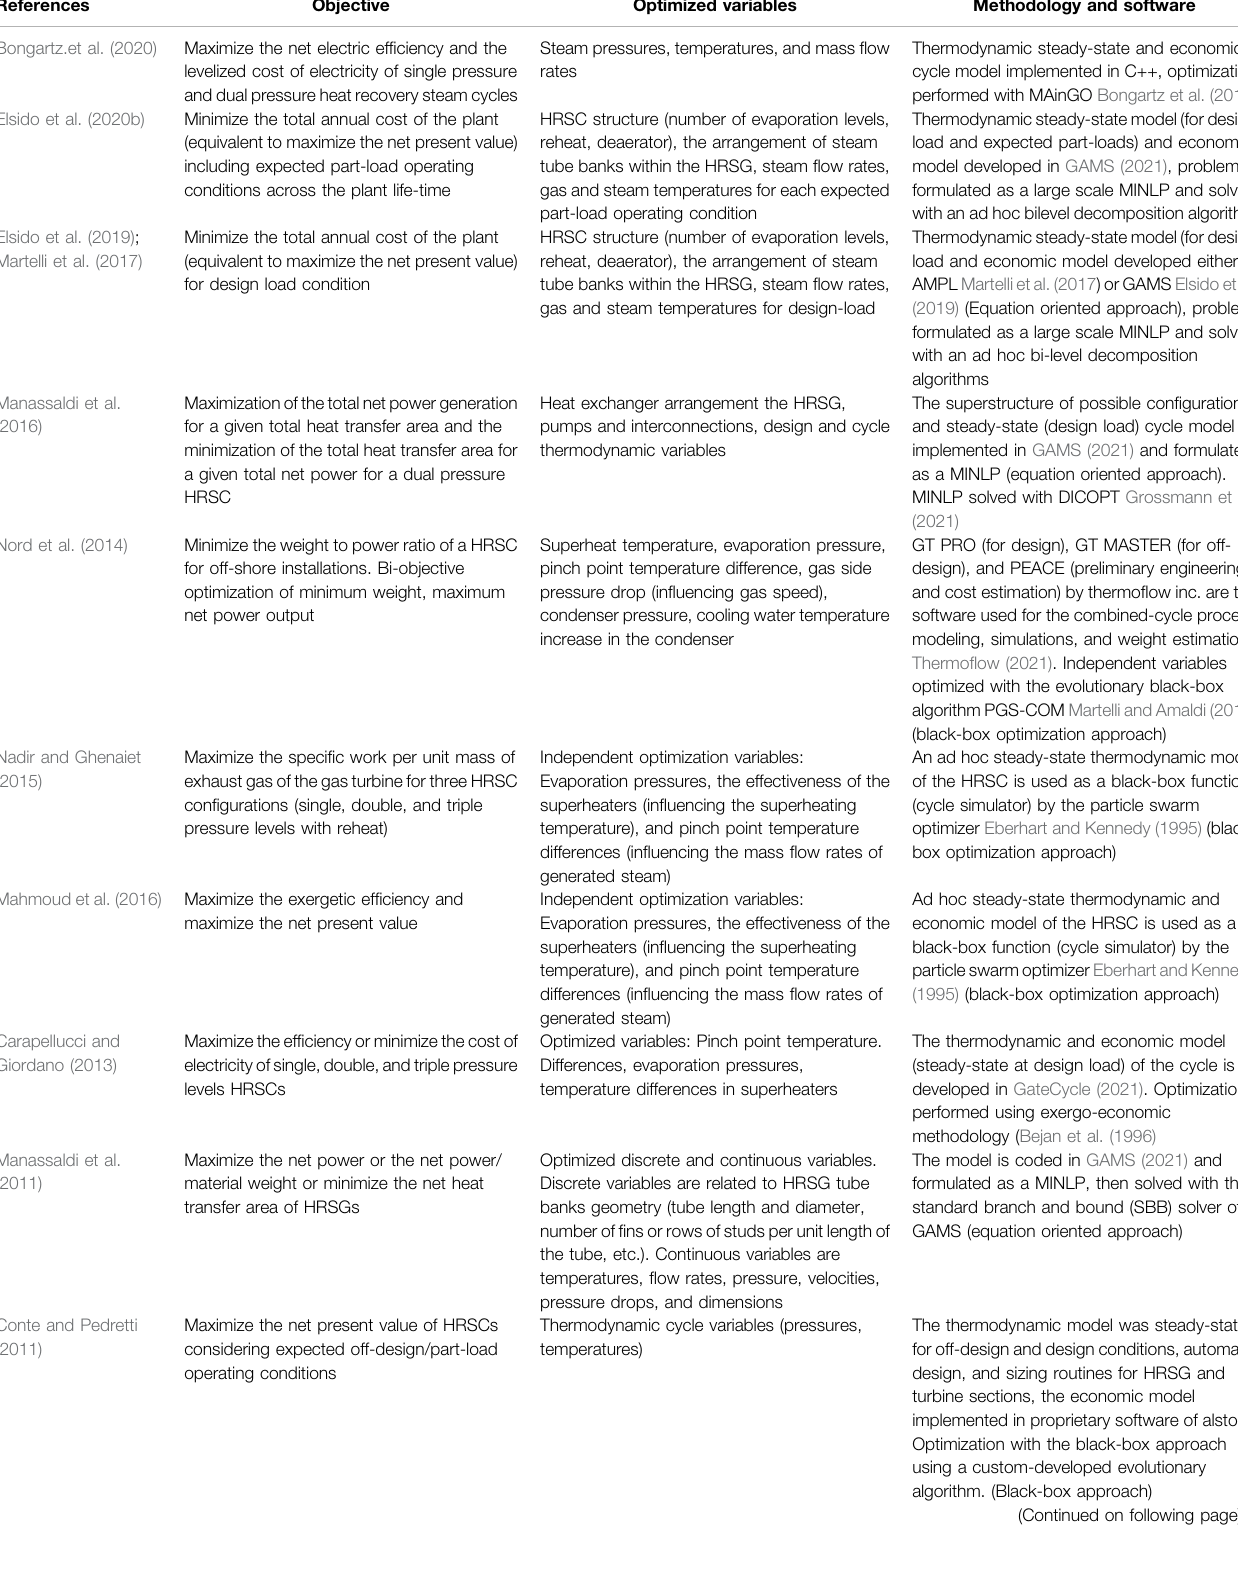
TABLE 2 | List of recent contributions on the optimization of heat recovery steam cycles for combined-cycle power